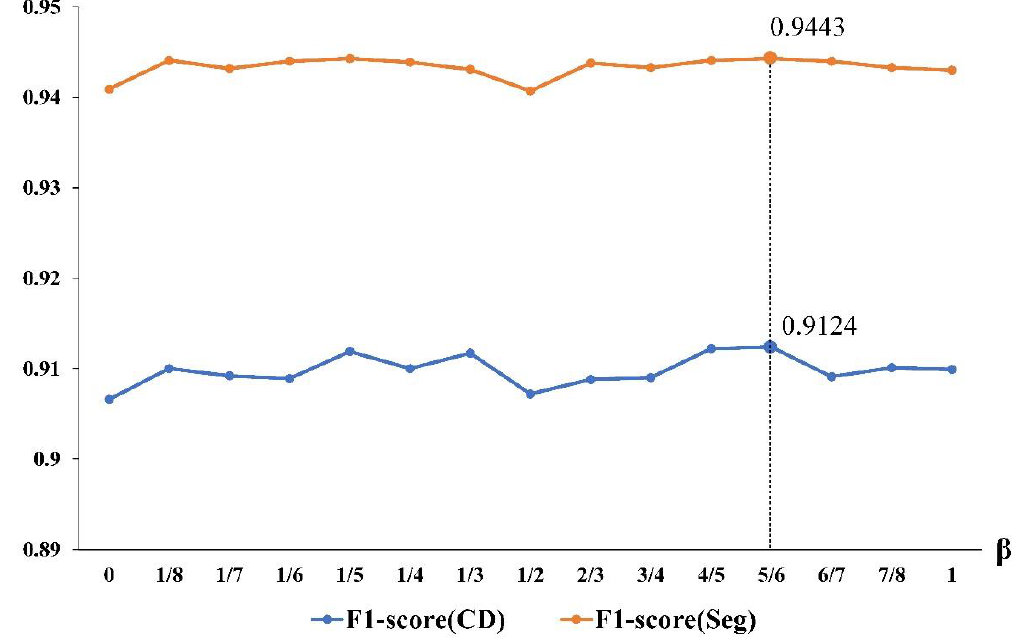
Figure 9. The influence of β value on the performance of MDESNet.